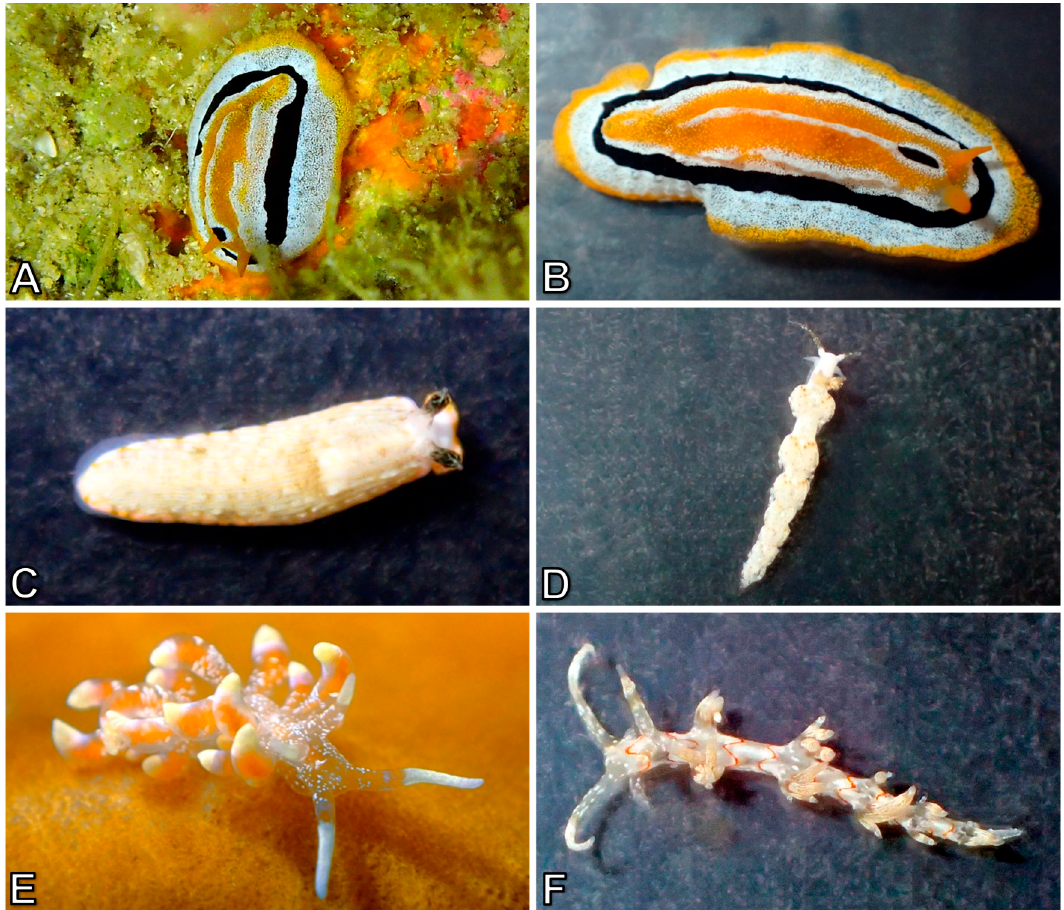
Figure 20. Nudibranchia - Doridina, Nudibranchia - Cladobranchia: ( A , B ) Phyllidia spec., Phsp17Bu-1; ( C ) Dermatobranchus spec. ( Dermatobranchus sp. 8 in Gosliner et al. [11]: 302), Desp8_17Bu-1; ( D ) Noumeaella spec. ( Noumeaella cf. sp. 6 in Gosliner et al. [11]: 368), Nosp6_17Bu-1; ( E ) Phyllodesmium poindimiei ; ( F ) Facelinidae spec., Fasp17Bu-1.